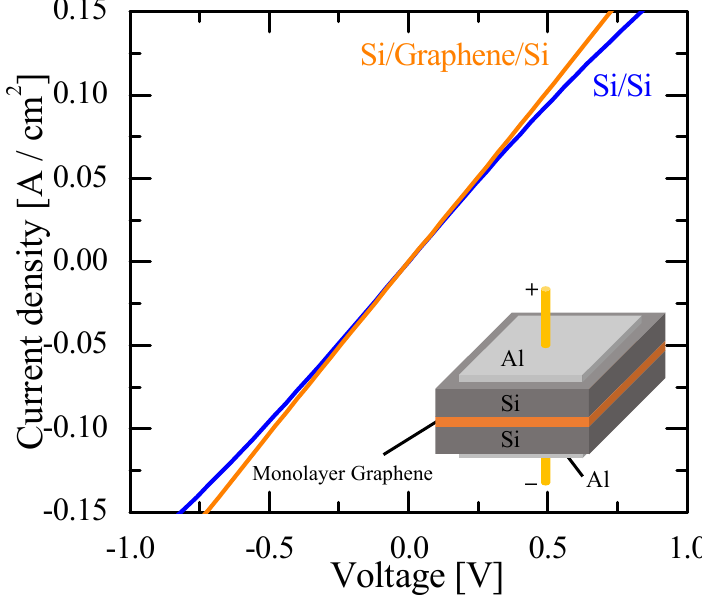
Figure 6. Current-voltage characteristics of the Si/monolayer graphene/Si double heterostructure and corresponding Si/Si control structure with the same doping concentration (~1 × 10 19 cm − 3 ) in the Si wafer.